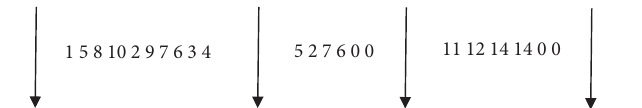
Figure 6: Example of natural number coding of LRP